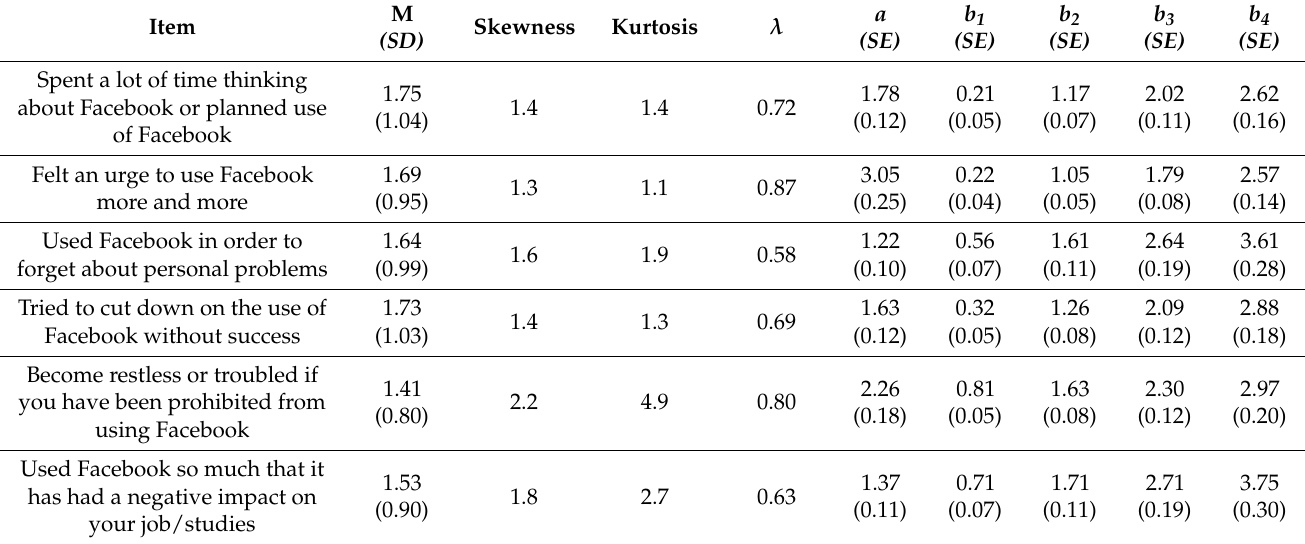
Table 1. Mean (with standard deviation in brackets), Skewness, Kurtosis, standardized factor loadings ( λ ), item discrimina- tion, and category threshold estimates (with the standard errors in brackets) of the items of the Bergen Facebook Addiction Scale